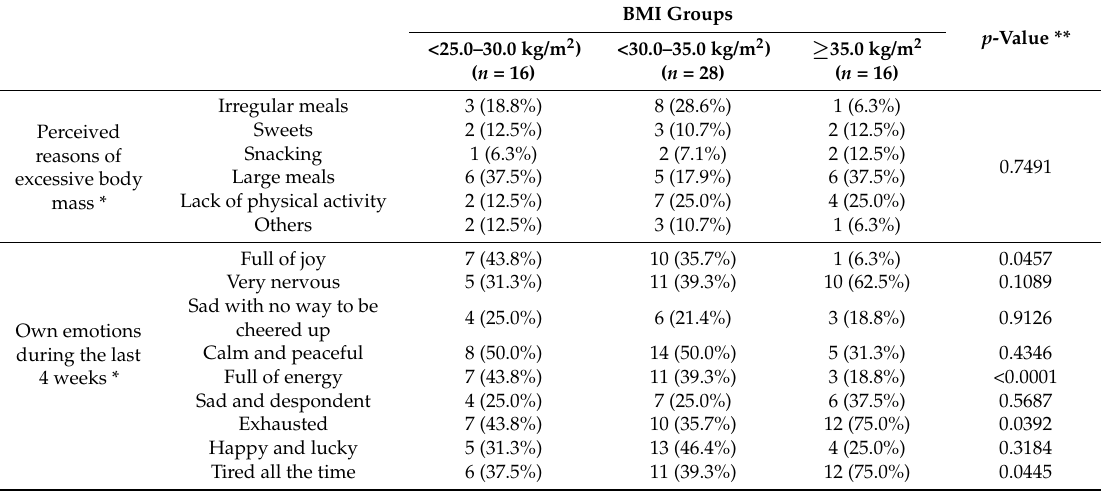
Table 6. The body mass beliefs, attitudes, and emotions of the studied group for the sub-groups stratified by BMI.